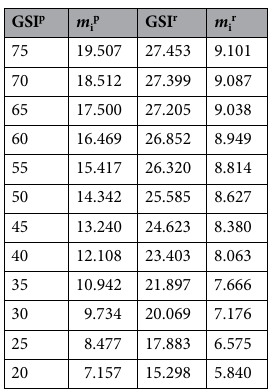
Table 5. Estimated values of m ip and m ir .